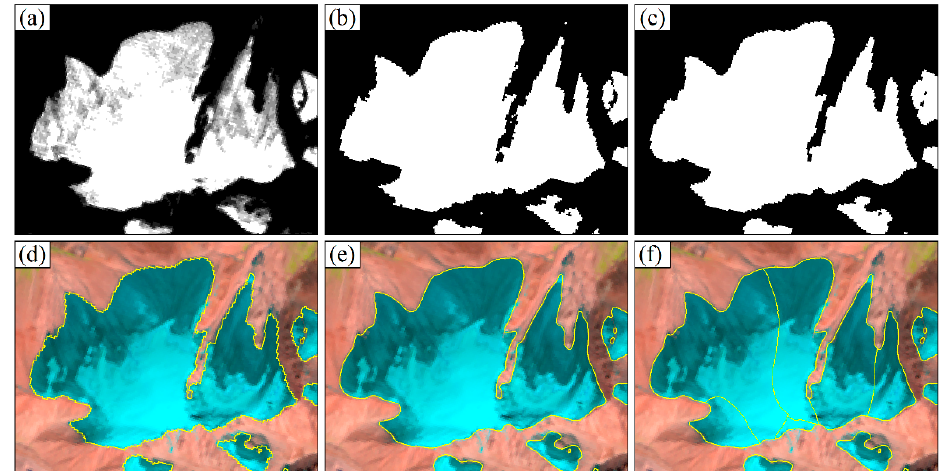
Figure 3. Bare ice boundary extraction (( a ) Band3/Band5 ratio image, ( b ) image with a threshold of 1.8, ( c ) image after using the median filter, ( d ) glacier outline in vector format, ( e ) image after manual revision, and ( f ) individual glacier outline; ( d – f ) Landsat Thematic Mapper (TM) image (Bands 5, 4, and 3); the image is LT51480312006240IKR00).